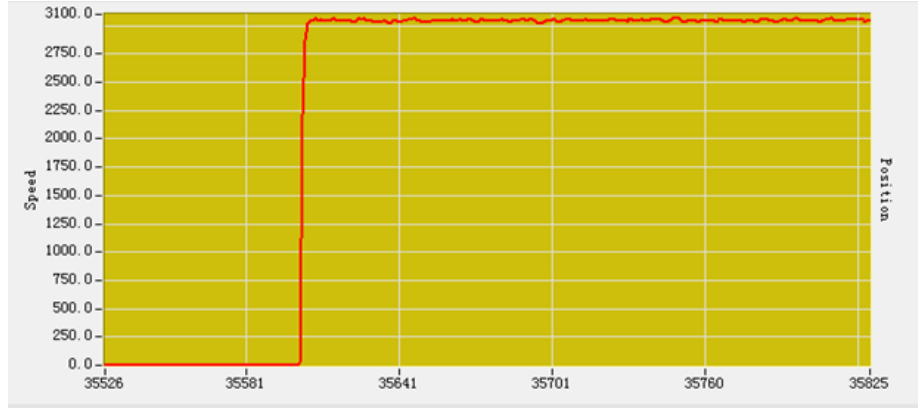
Figure 16. Motor driver.